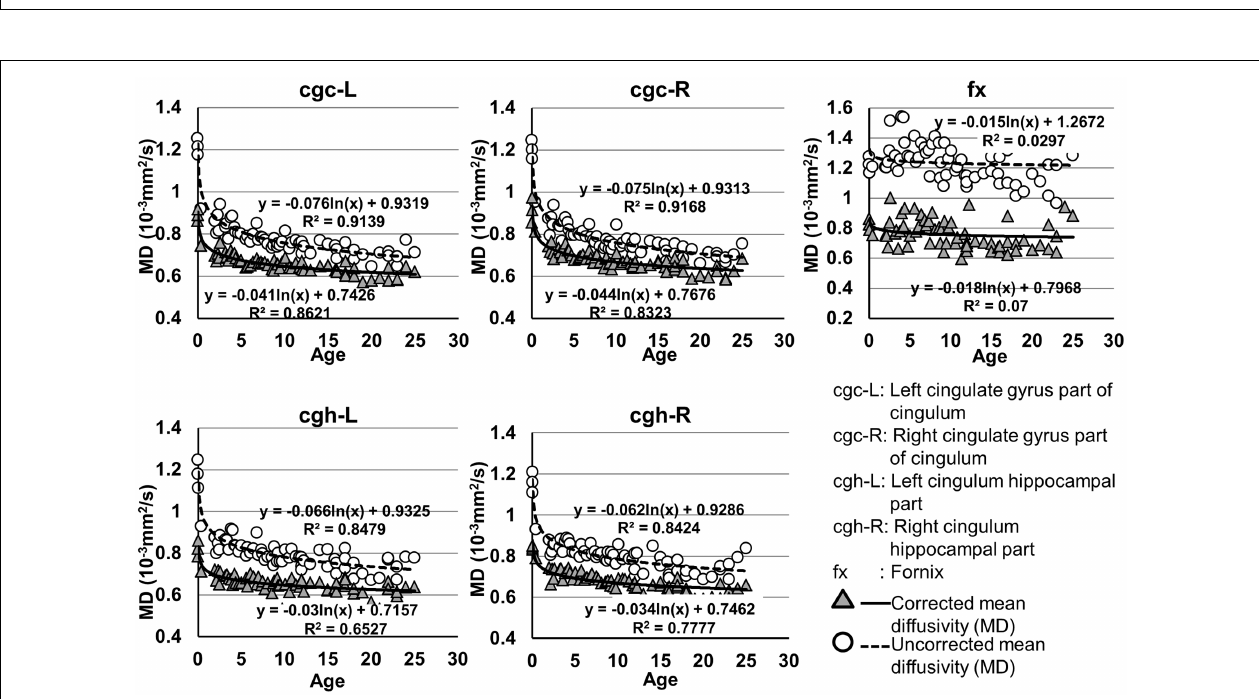
FIGURE 4 |Age-dependent changes of uncorrected and corrected mean diffusivity (MD) measurements of limbic tracts . R 2 and fitting equations are listed in each panel.